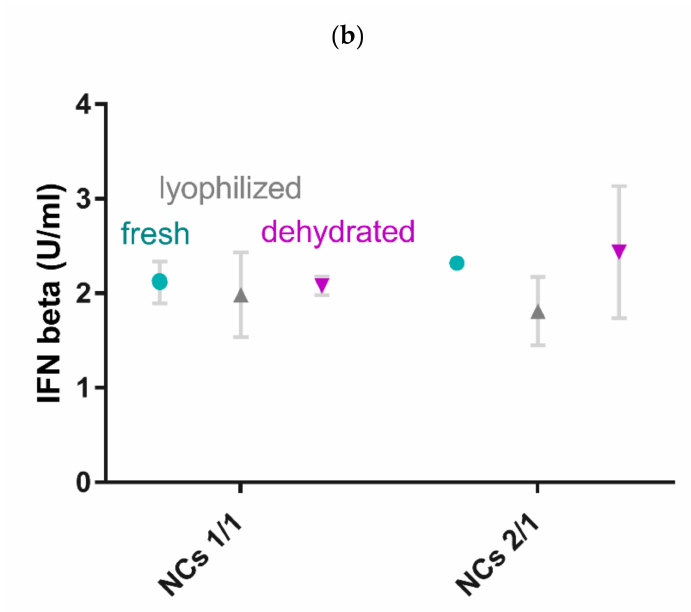
Figure 6. DLS, ( a ) storage stability of lyophilized and dehydrated NCs compared to the freshly prepared ones. ( b ) ELISA, IFN beta, graph overlap of linP25 and 2/1 linP25/cGAMP NCs; n =